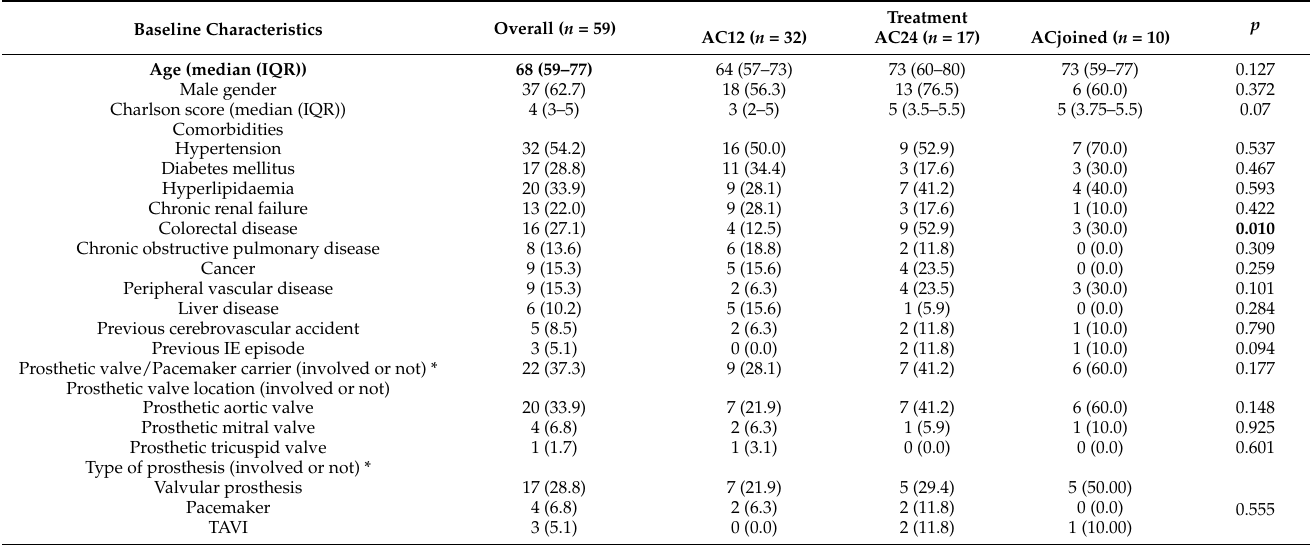
Table 1. Baseline